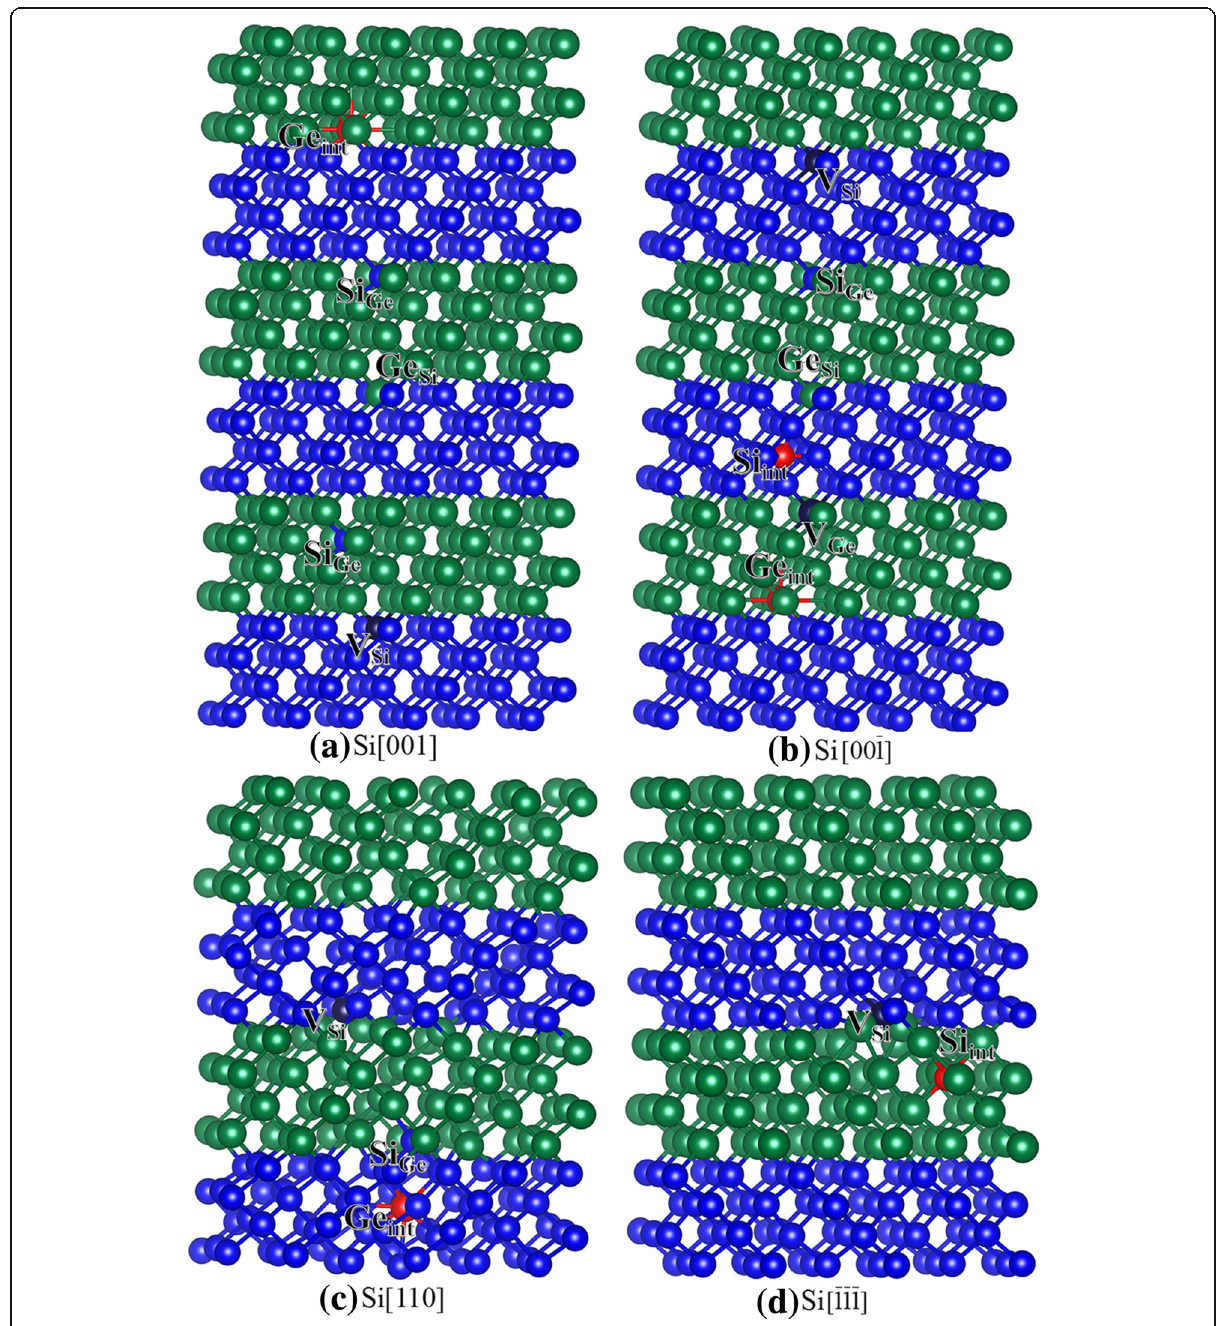
Fig. 4 a – d Schematic view of geometrical structures of damage Si/Ge superlattice after Si recoil events. The blue and green spheres represent the Si and Ge atoms, respectively. V X : X vacancy ( X = Si or Ge); X int : X interstitial ( X = Si or Ge); X Y : X occupying the Y lattice site ( X and Y = Si or Ge). The purple and red spheres represent the vacancy and interstitial defects,